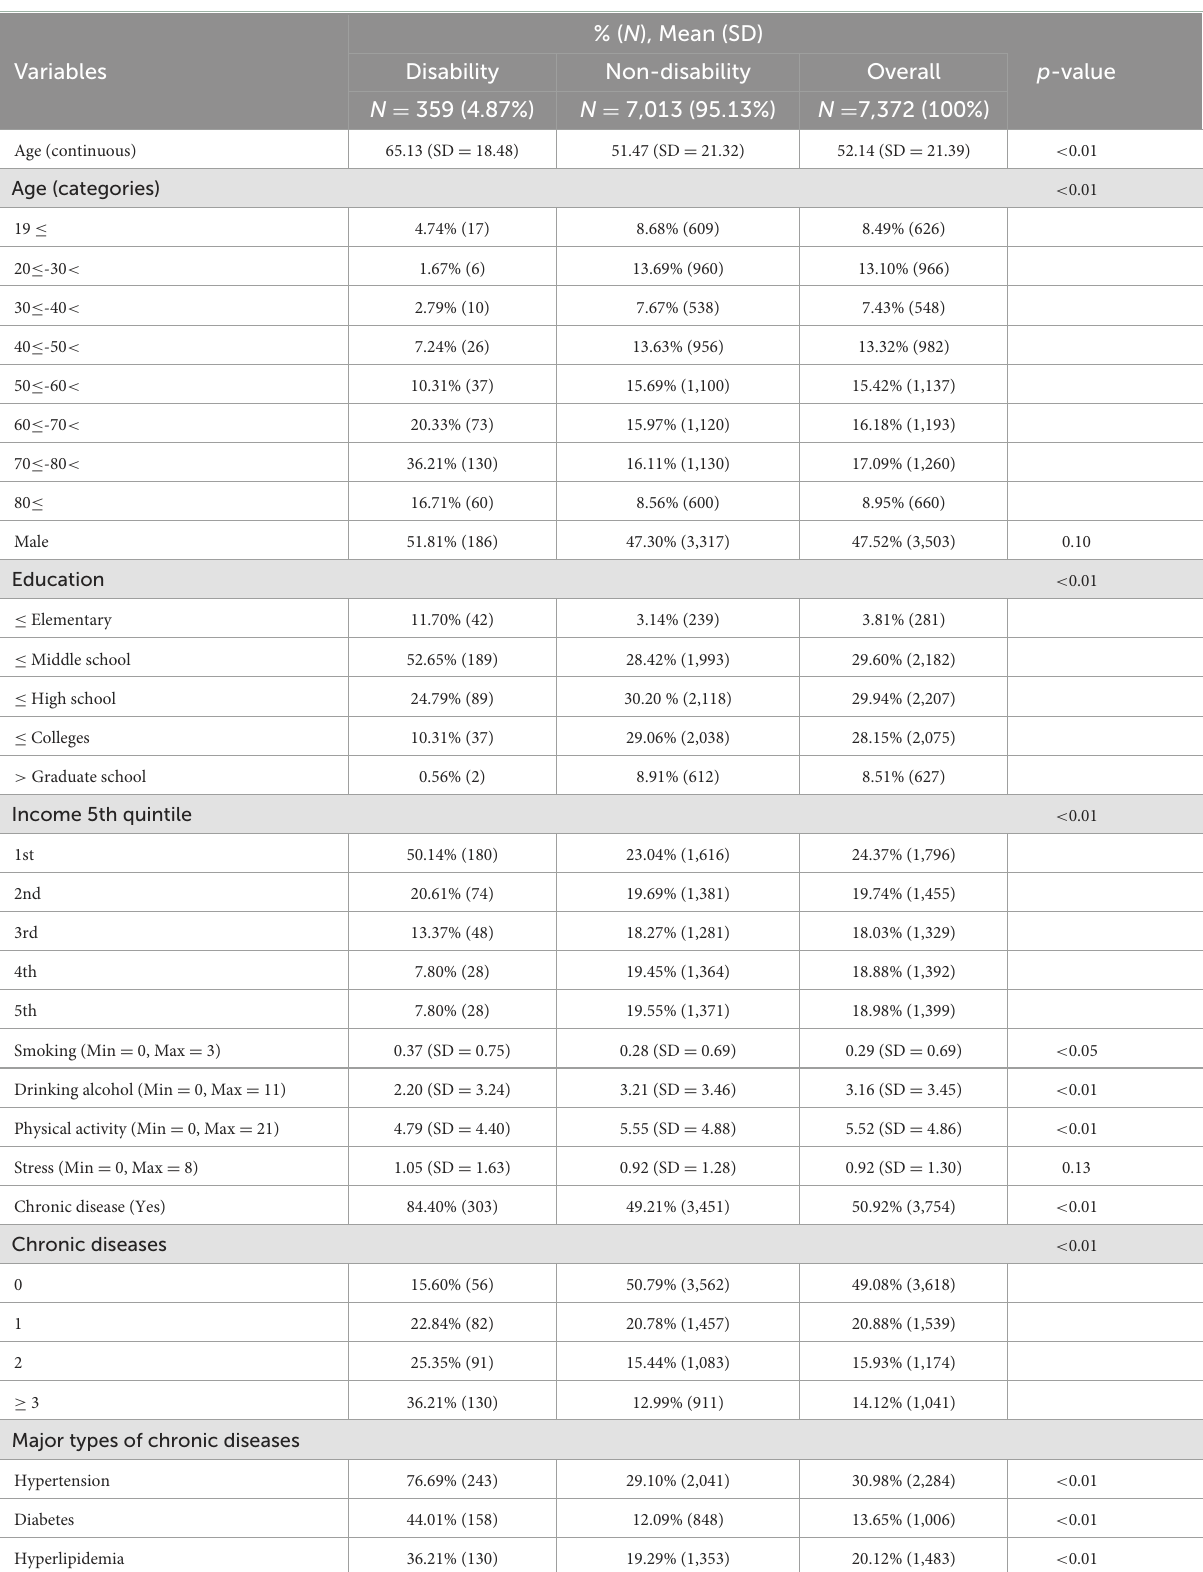
TABLE 3 Descriptive statistics descriptive statistics of study sample with disability (year of